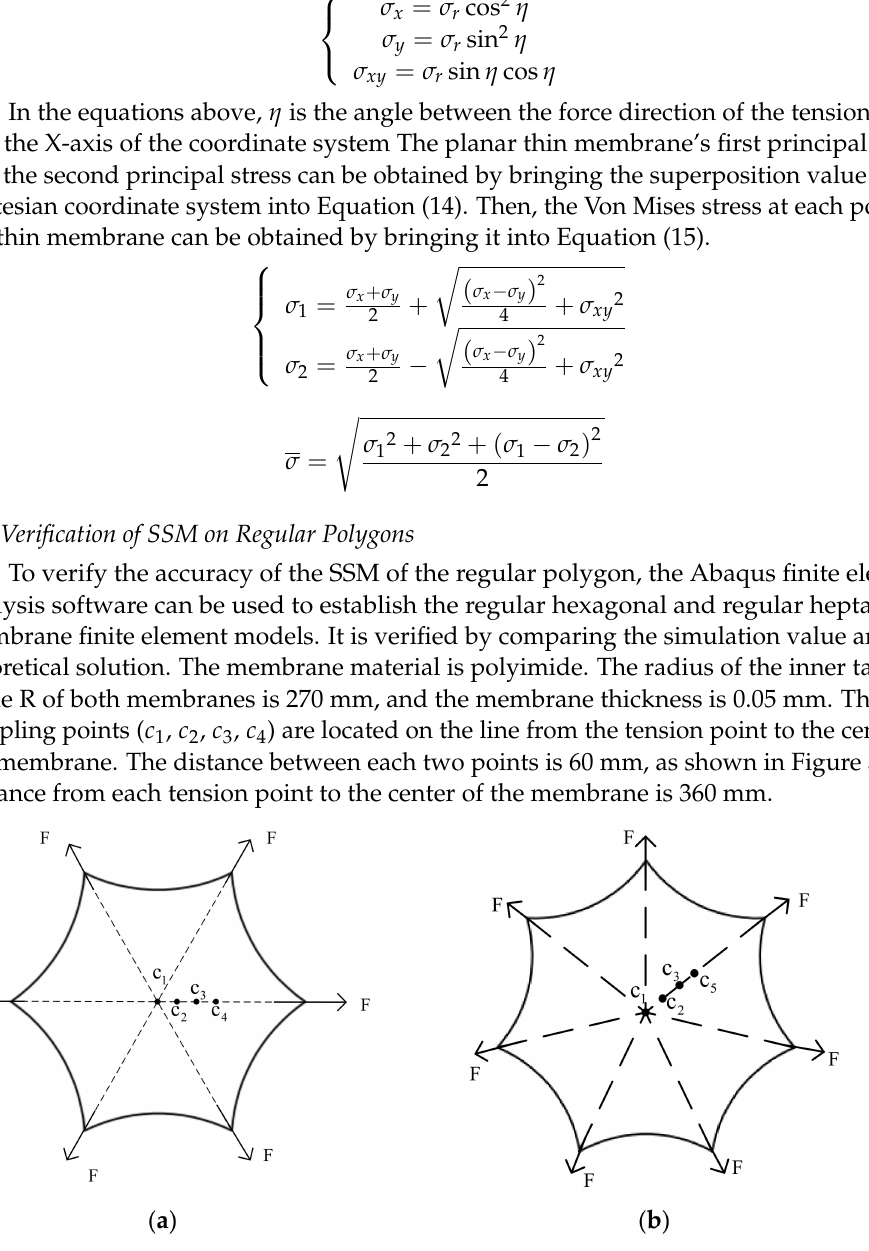
Figure 5. Example of stress superposition in ortho-hexagonal and ortho-heptagonal membranes. ( a ) Positive hexagonal sampling point distribution; ( b ) Positive heptagonal sampling point distribution. The membrane size and force form in Figure 5 is input to Abaqus for static